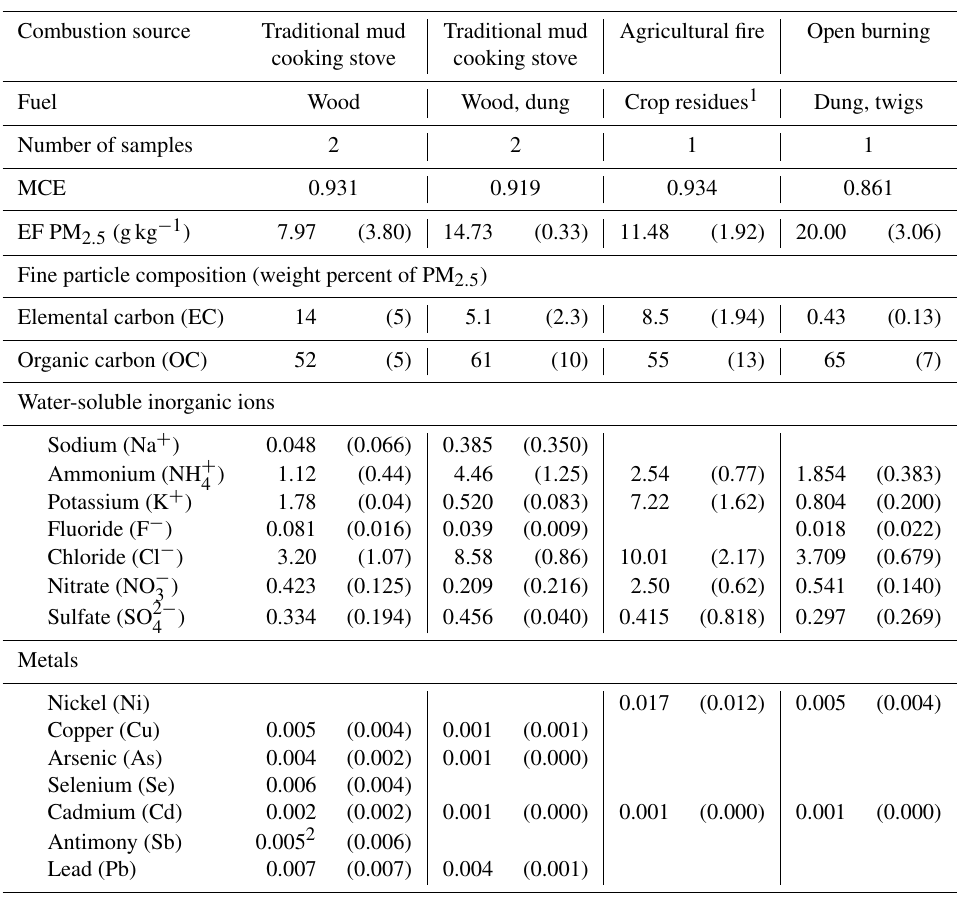
Table 2. Summary of emissions data for select biofuel combustion sources, including modified combustion efficiency (MCE), emission factors for PM 2 . 5 (gkg − 1 ) , and fine particle composition (as PM 2 . 5 weight percent). Errors are shown in parentheses. Missing values are below the method detection limits. For sources represented by a single sample, errors were propagated from analytical uncertainties. For sources represented by replicate samples, errors were calculated as 1 standard deviation of the